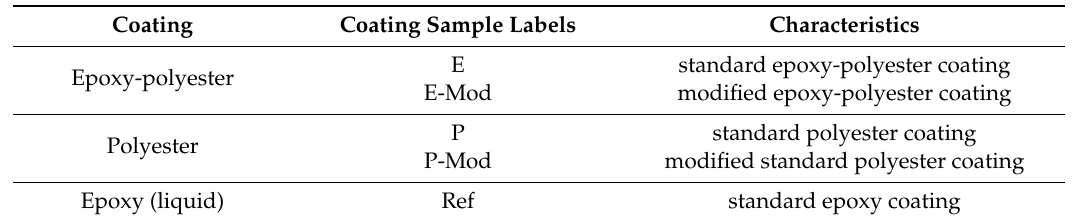
Table 1. Sample labels with respective